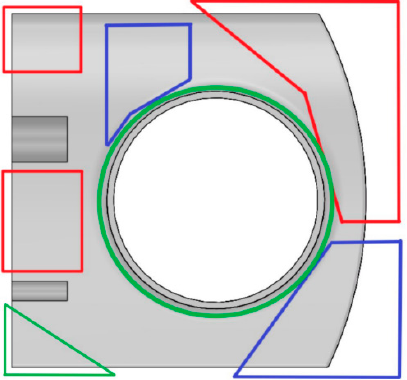
Figure 15. Material removal process in topology optimization.